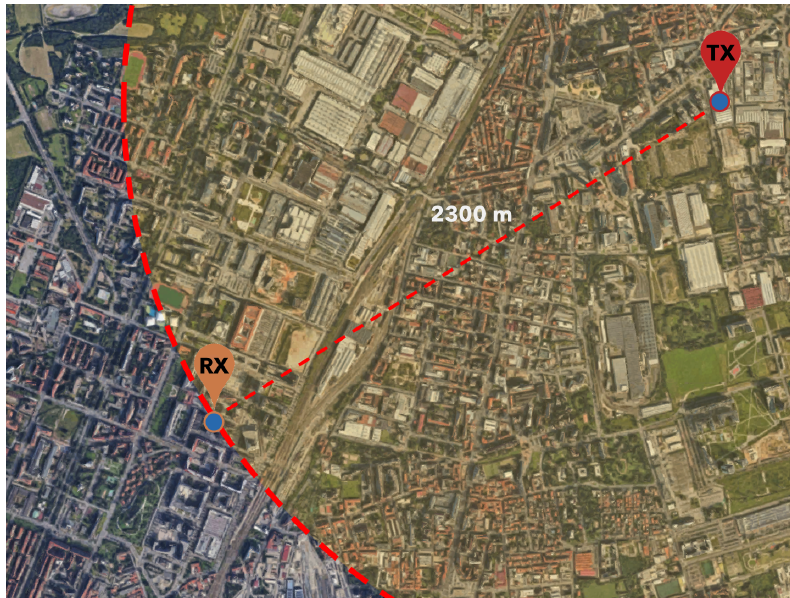
Figure 8. Urbanization of the northern Milan area, where the test took place.